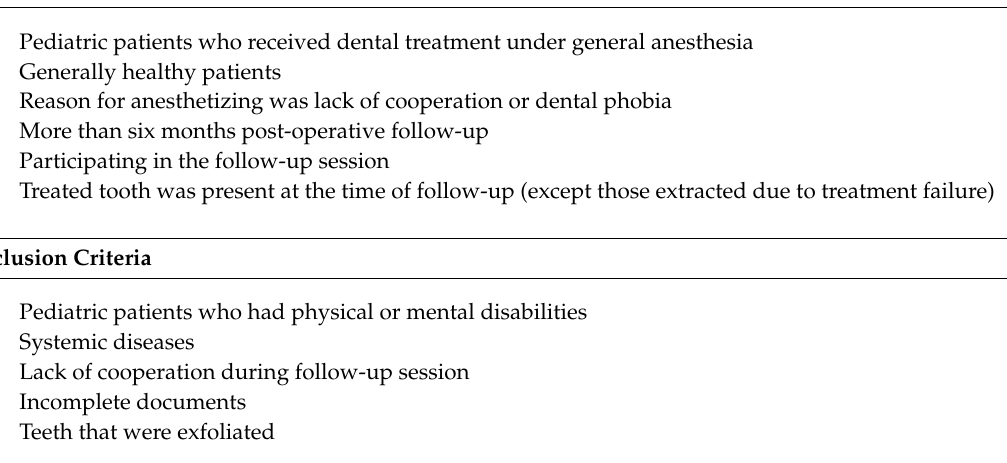
Table 4. Inclusion and exclusion